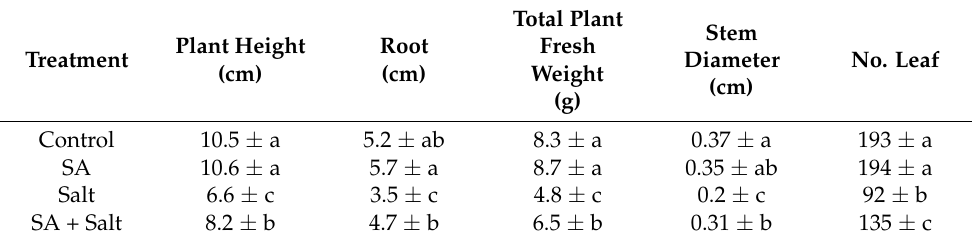
Table 1. Growth parameters of salicylic acid on salinity-stressed St. John’s wort seedlings. St. John’s wort seedlings picture.